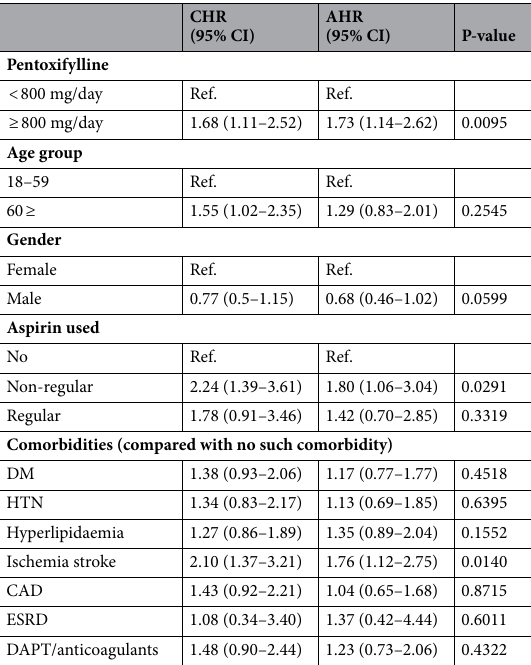
Table 3. Risk factor of major bleeding event in patients with chronic kidney disease receiving pentoxifylline. AHR, adjusted hazard ratio; CAD, coronary artery disease; CHR, crude hazard ratio; DAPT, dual antiplatelet therapy; DM, diabetes mellitus; ESRD, end-stage renal disease; HTN, hypertension.